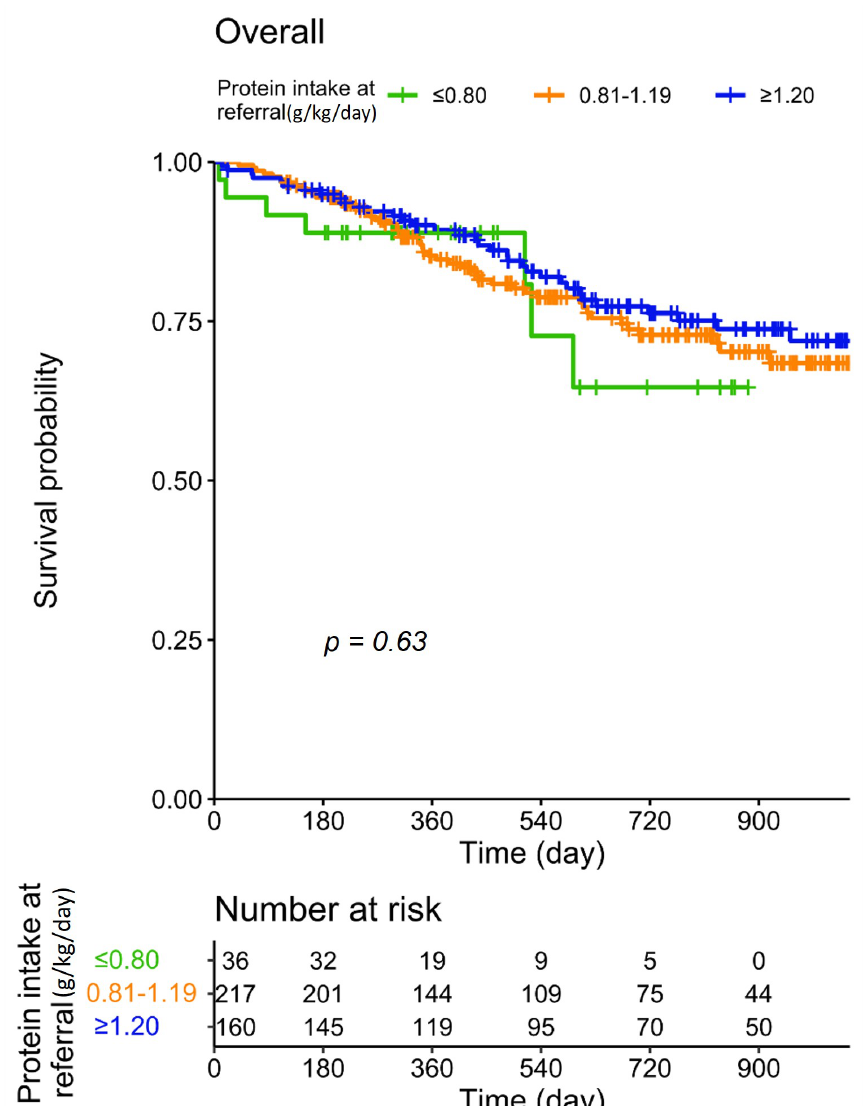
Figure 1. Patient survival according to protein intake at baseline.